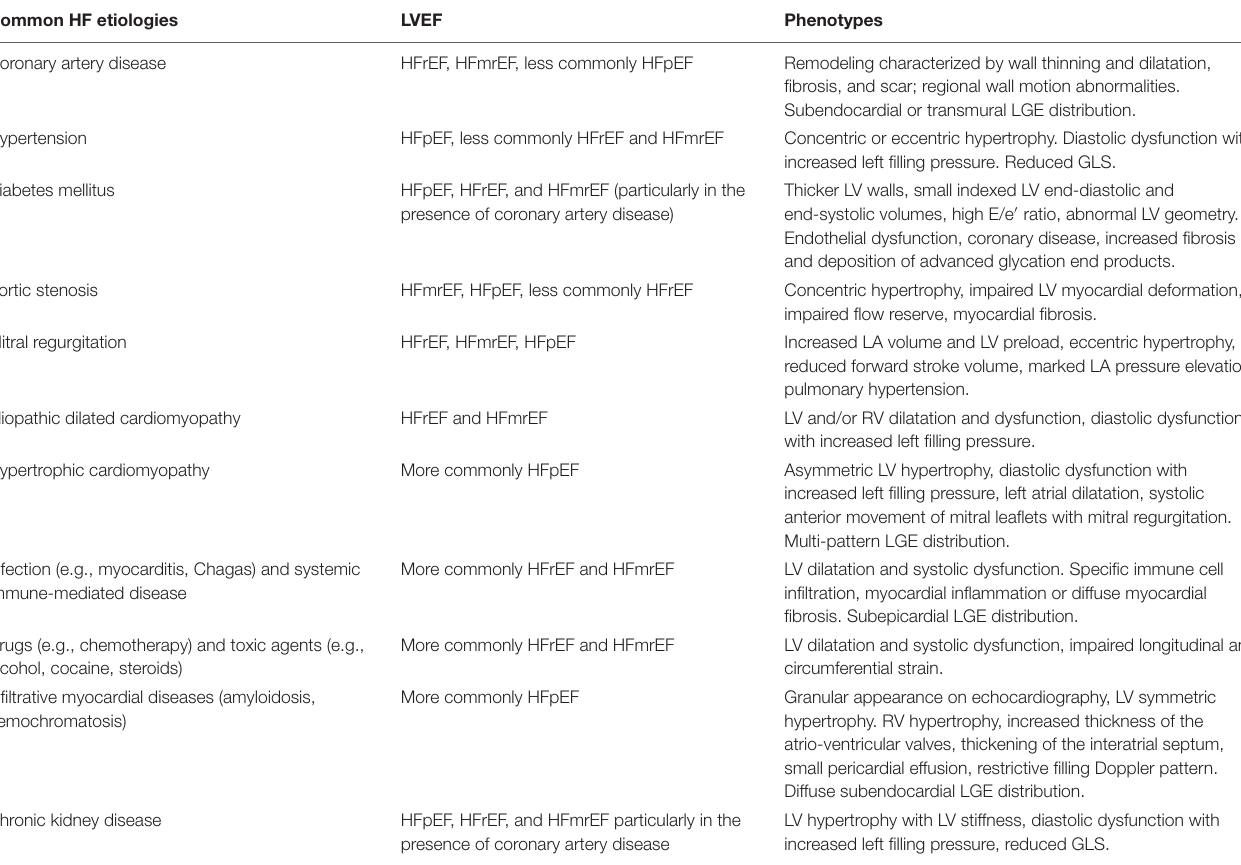
TABLE 1 | Association between main HF etiologies and LVEF